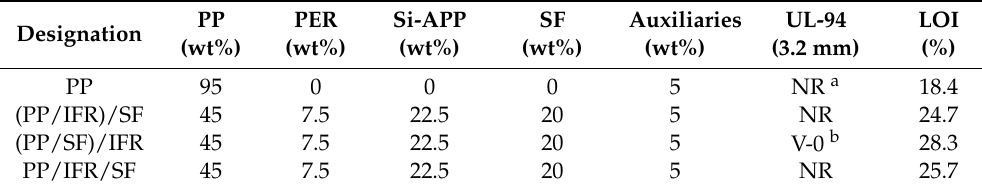
Table 1. Formulation and UL-94 rating, as well as limiting oxygen index of original PP and PP/SF composites.